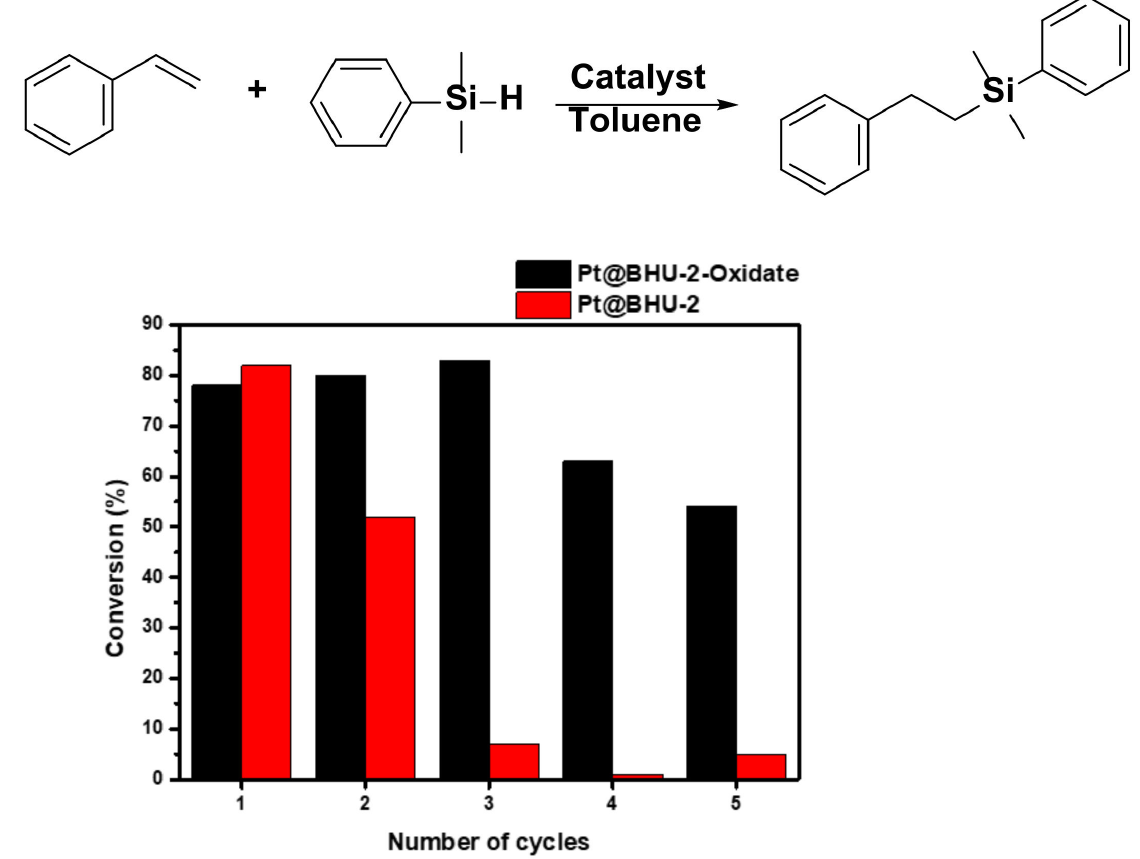
Figure 5. Recycling investigations of Pt@BHU-2 and Pt@BHU-2-Oxidate in the addition reaction between dimethylphenylsilane and styrene. Notice that 4 and 5 can achieve the same conversion rate for 13 h. Reaction conditions: styrene (10.42 mg, 0.1 mmol), dimethylphenylsilane (27.25